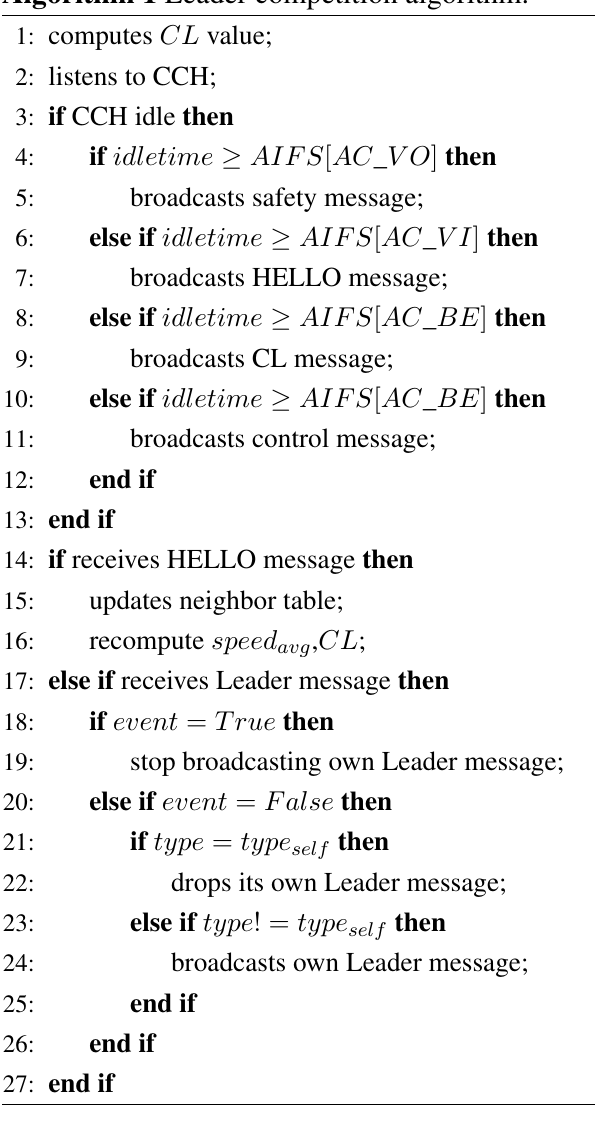
Algorithm 1 Leader competition